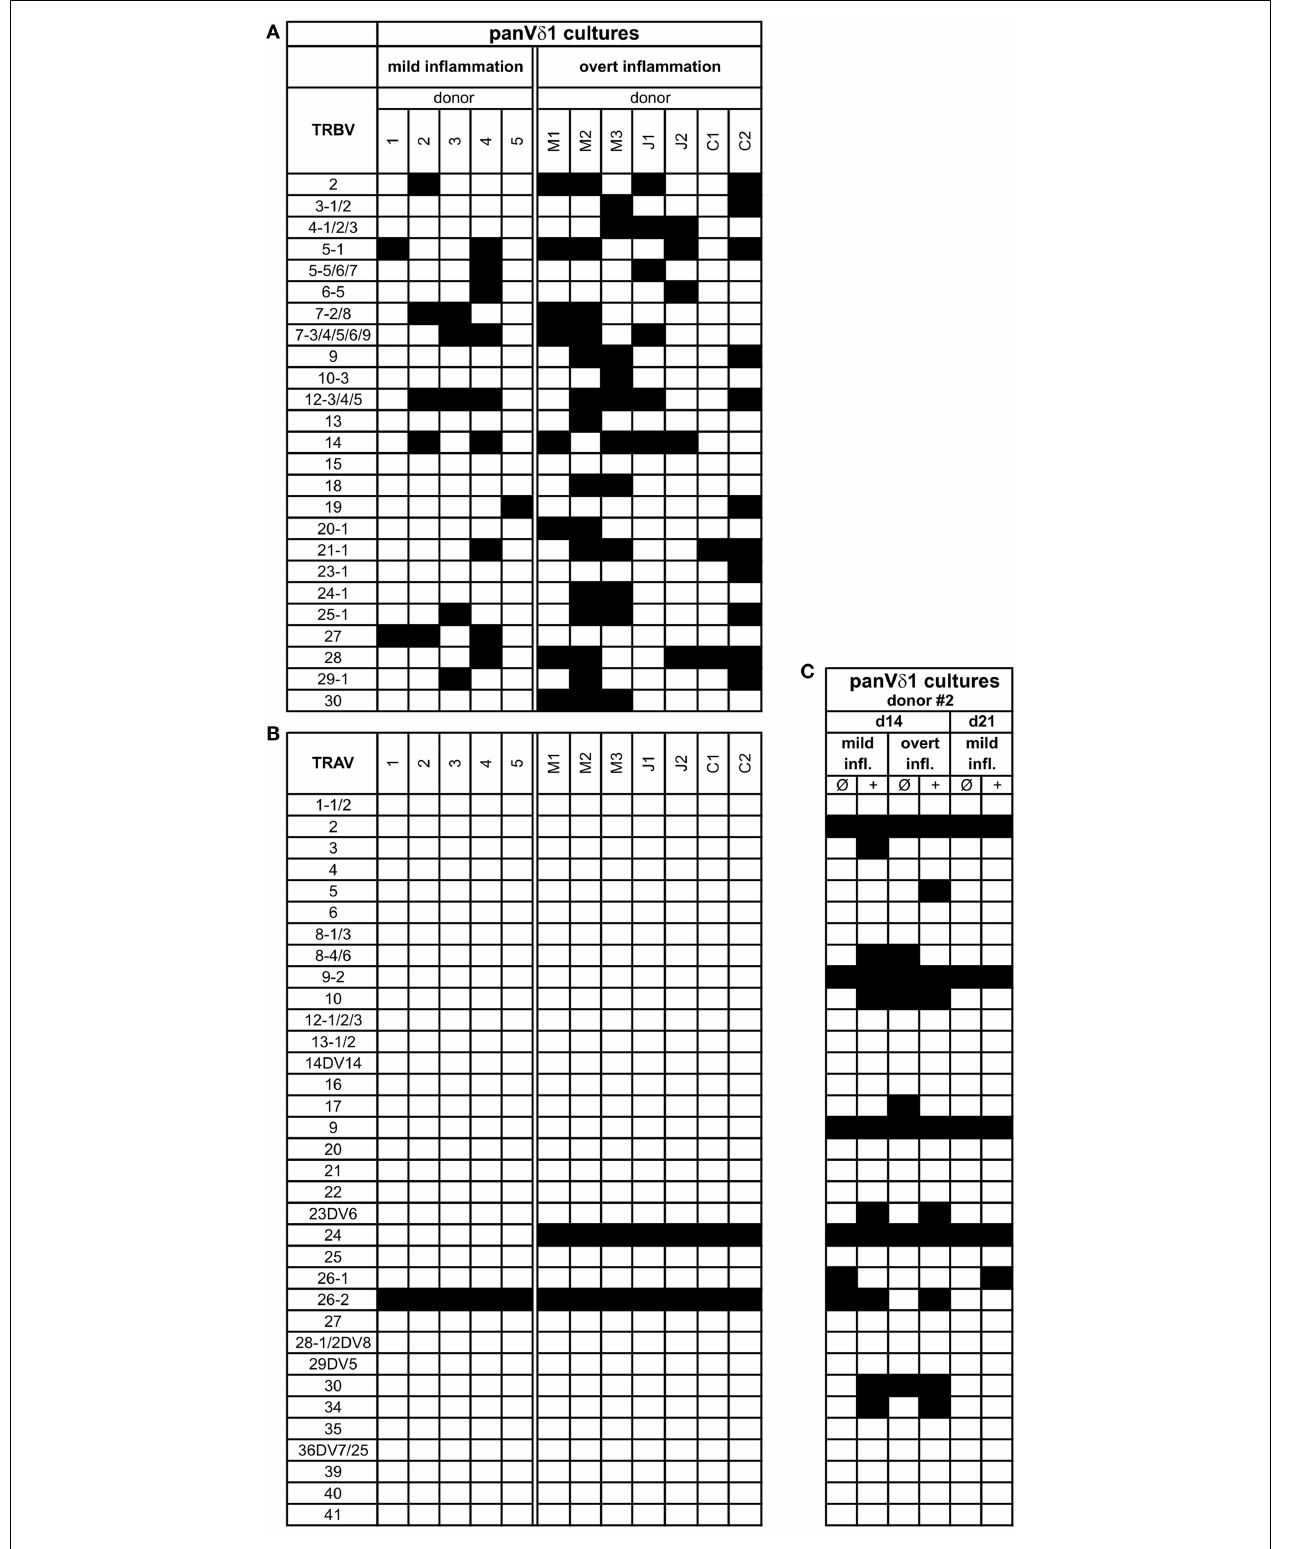
V α -segment usage of panV δ 1 + T cells from one donor (#2) in different modified inflammatory environments. + ,Treatment combined with anti-CD40; IL-15 (10ng/mL) was added to all cultures. Black squares indicate expression of transcripts of rearrangedTCR